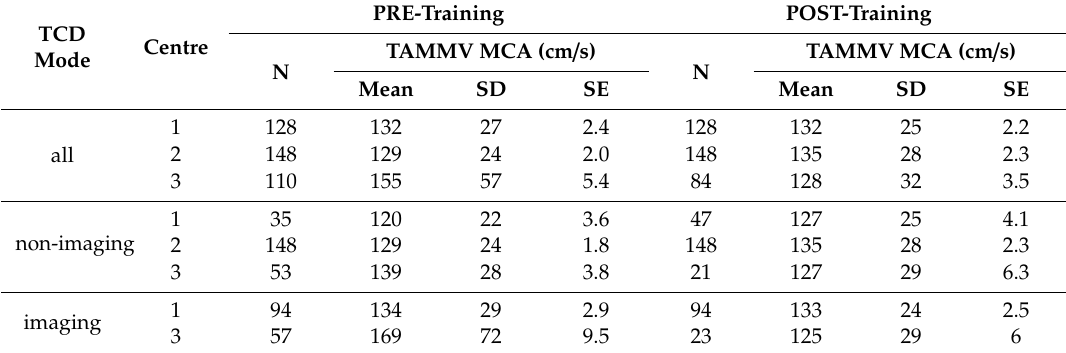
Table 4. Time-averaged mean of the maximum velocity (TAMMV) from the middle cerebral